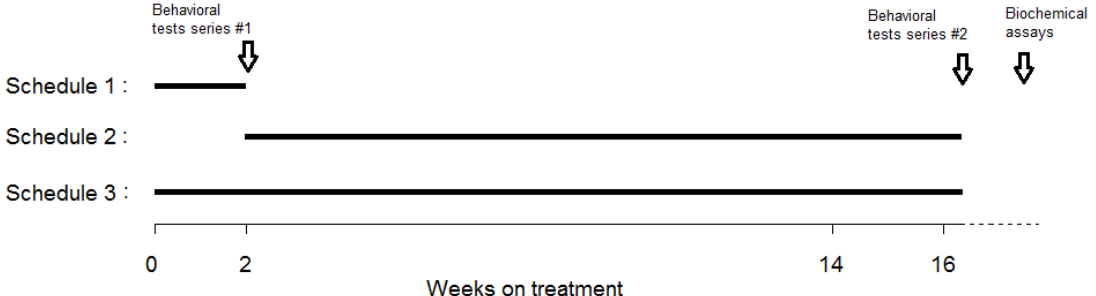
Figure 8. Protocol timeline. Schematic representation of the treatment protocol. MI rats treated with DV were distributed in schedules 1, 2 and 3. Lines represent DV treatment. Sham rats treated with DV were distributed only in schedule 3. Other MI and sham rats received only vehicle. Behavioral test series #1: social interaction test and passive-avoidance step-down test; behavioral test series #2: